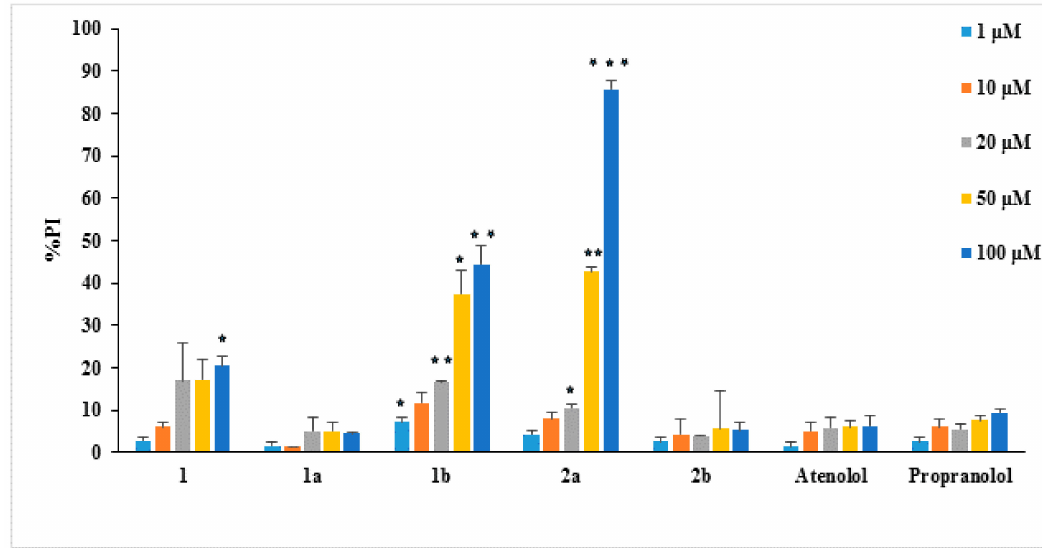
Figure 1. Cytotoxicity of compounds on L929 cells (24 h incubation), as PI% values. The lines on the bars indicate standard deviation. Asterisks indicate statistical significance of difference between the respective compound and atenolol at the respective concentration (* p < 0.05, ** p < 0.01, *** p <